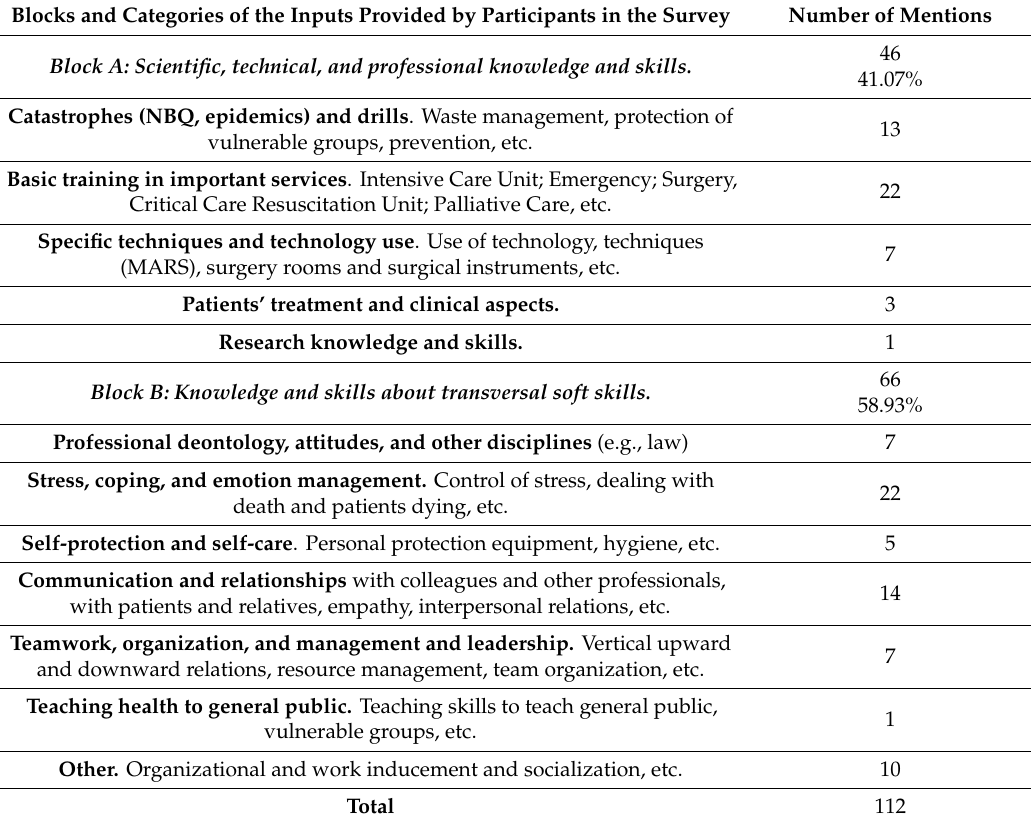
Table 2. Content analysis of inputs provided by the nurses in the survey. Categories and frequencies of items mentioned in each